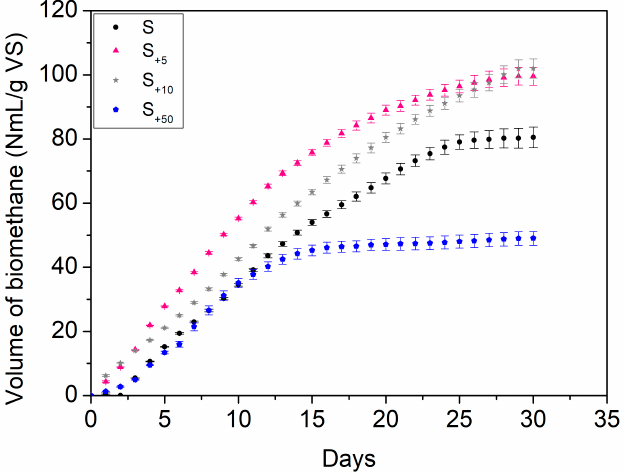
Figure 4. Average production of cumulative net volume of methane (NmL·g − 1 VS ) during anaerobic digestion without NPs (S) and with NPs addition ( S +5 , S +10 , S +50 ). Low concentrations of NPs (5 mg·g − 1 S and 10 mg·g − 1 S ) improved the biogas production compared to the control ( S ). Sample S showed an increasing trend up to the 25th day and